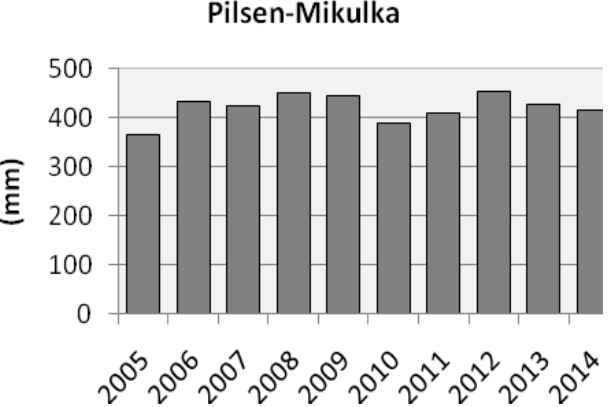
Fig. 9. Pilsen-Mikulka, evaporation from water surface between 1 st May and 30 th September